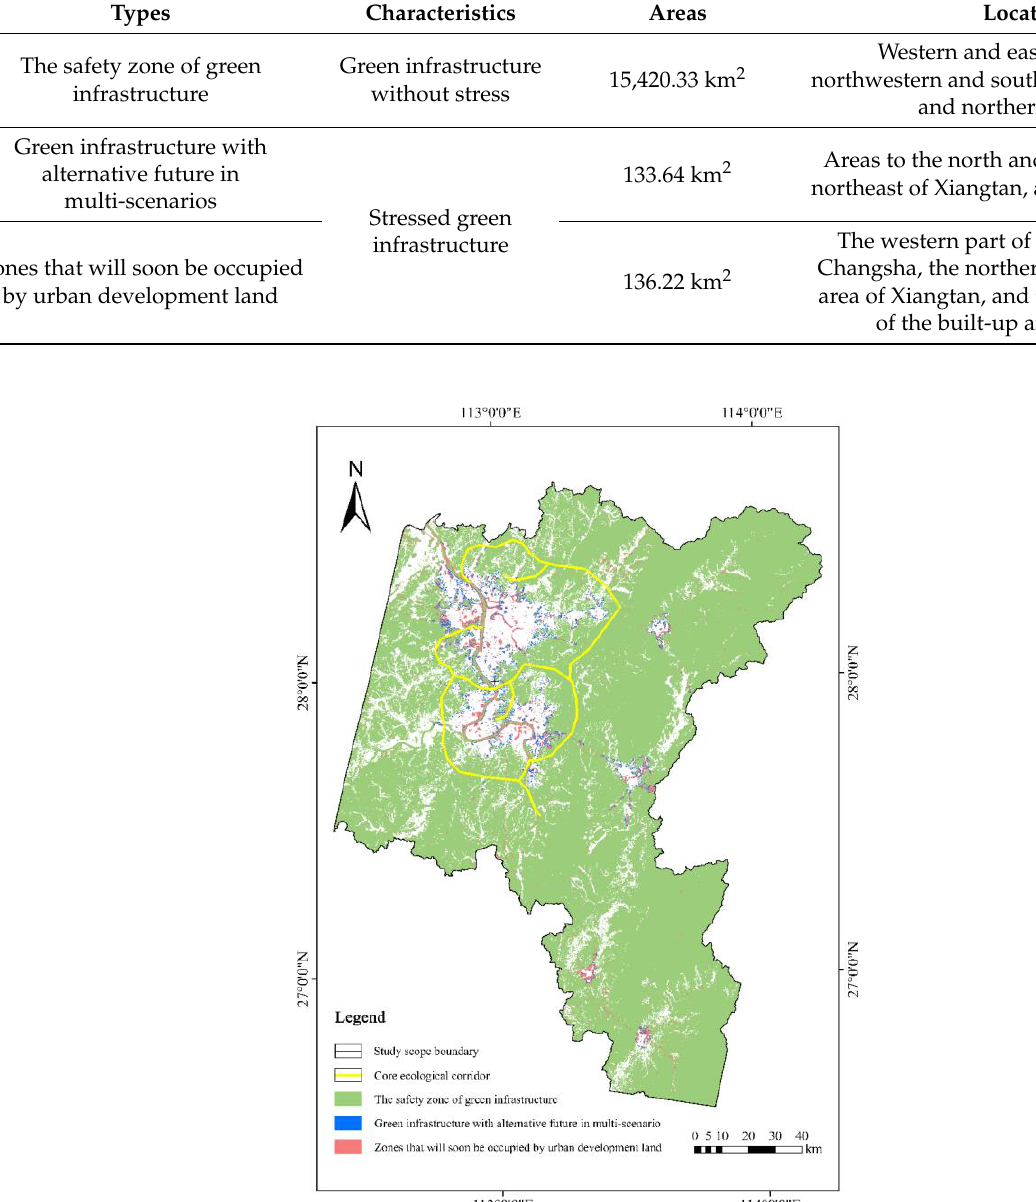
Table 6. Different control areas of the green infrastructure.